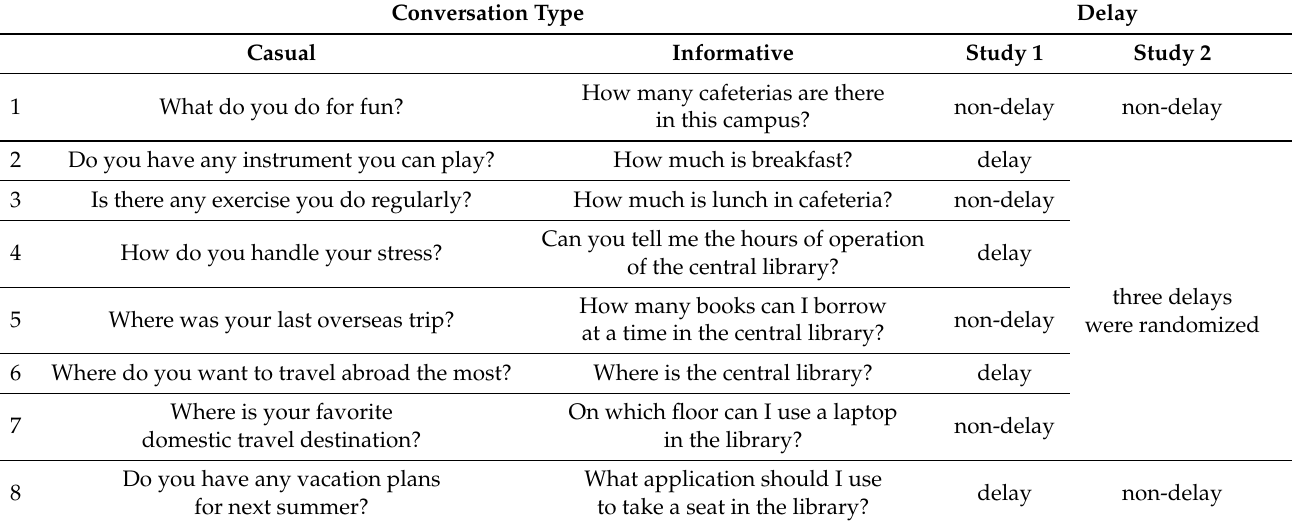
Table 1. Conversation examples and the locations of delayed